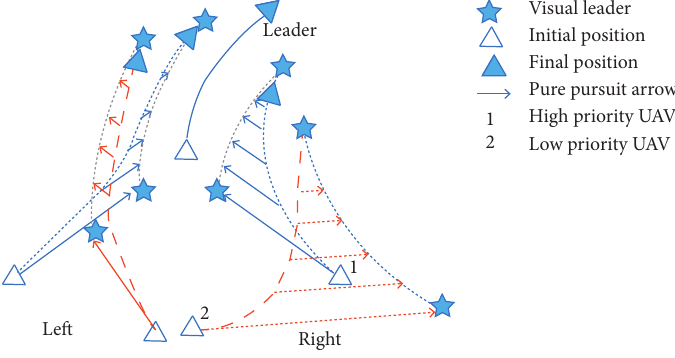
Figure 3. Two tracking strategies according to PP guidance inspiration. Left: without priority; Right: with priority. According to the PP guidance inspiration, some collision avoidance roles are inherently considered in the priority hierarchical tracking. Figure 4 shows the major critical situation. Left-hand tracking (without priority) leads to a collision at the moment of approximation (Fig. 4a) while right-hand tracking has its critical situation where higher priority UAV is located in the LOS between lower priority UAV and virtual waypoint at the moment of approximation in the time t . so in the next moment, the strategy leads to no collision term with a higher probability, as shown in Fig. 4b.